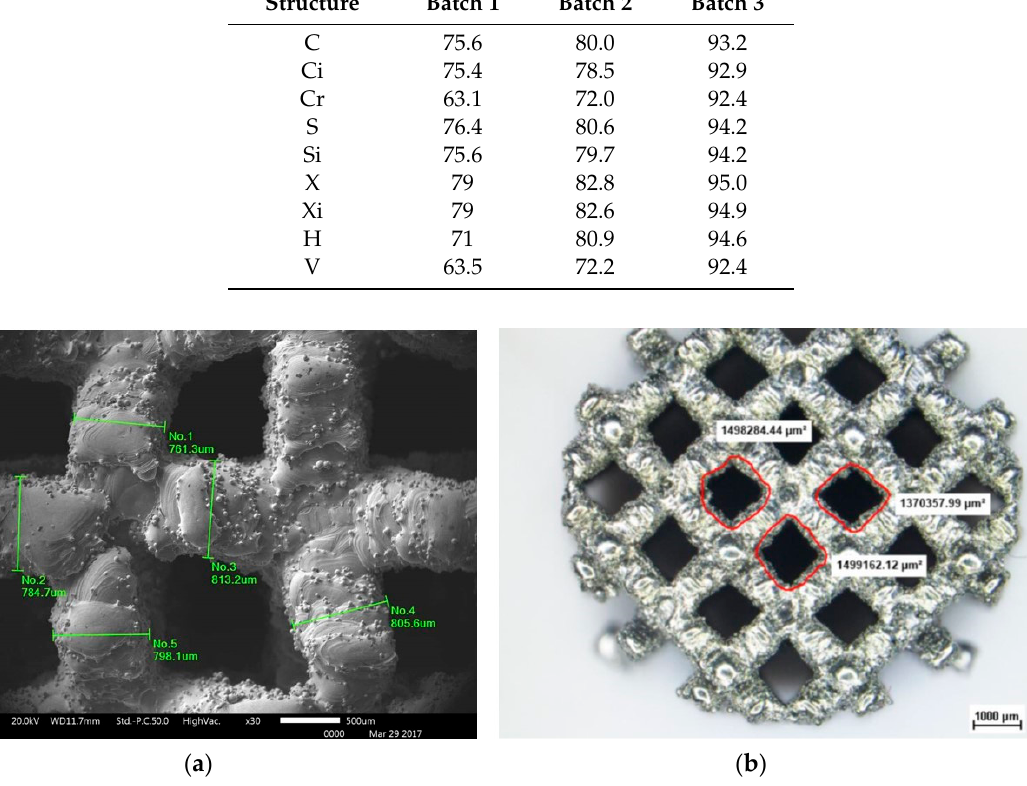
Figure 3. Examples of the determination of the strut and the pore size in the C structure. ( a ) strut size, ( b ) pore